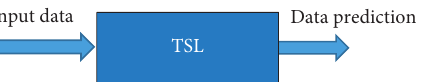
Figure 12: Model of Tensorflow